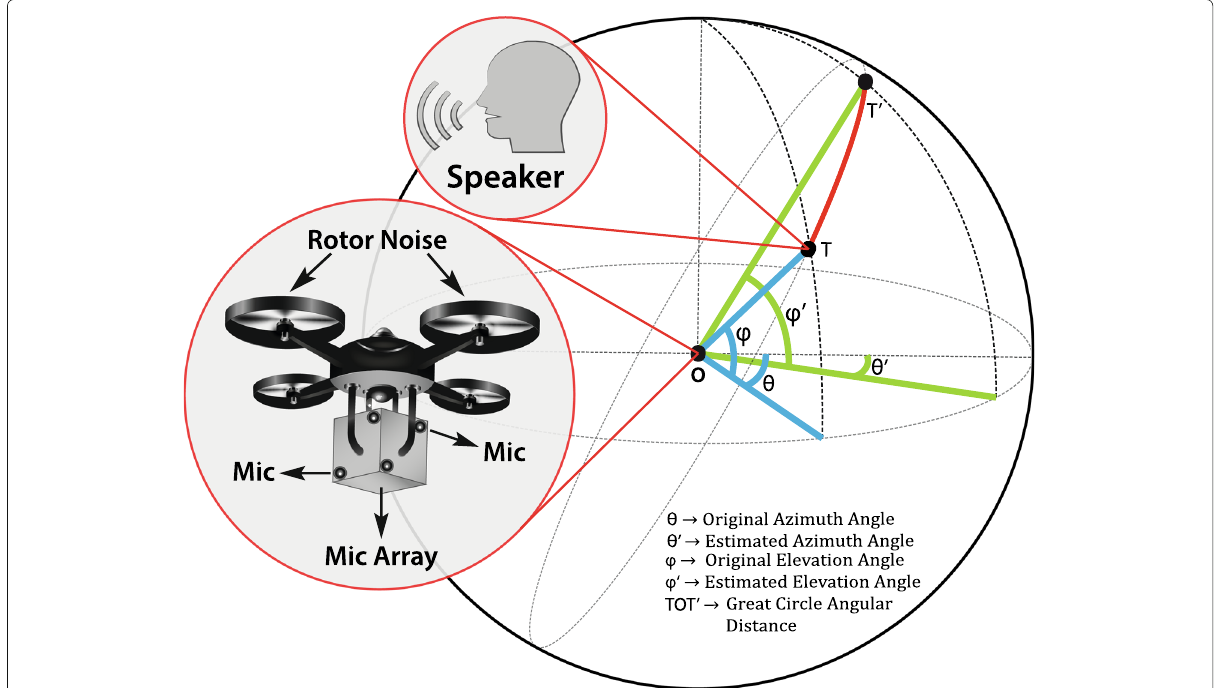
Fig. 1 Graphical representation of drone-embedded SSL. The UAV in this figure was taken from Freepik.com with permission